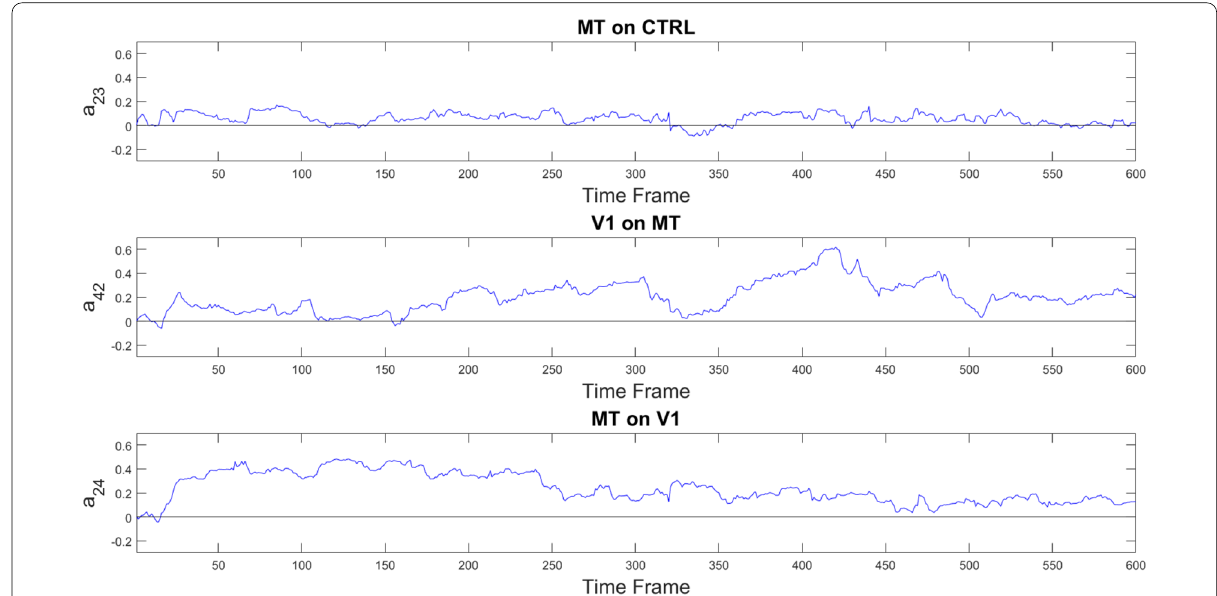
Fig. 10 Plots in blue color show the PF-estimated time courses of three representative hidden parameters a ij in the case of the 4-node visual network, estimated in real fMRI data in one subject. Top panel depicts the coefficient describing the negligible causal effect exerted by area MT over the control area. Central and bottom panels represent the non-symmetrical causal effect exerted by the V1 area over MT and viceversa